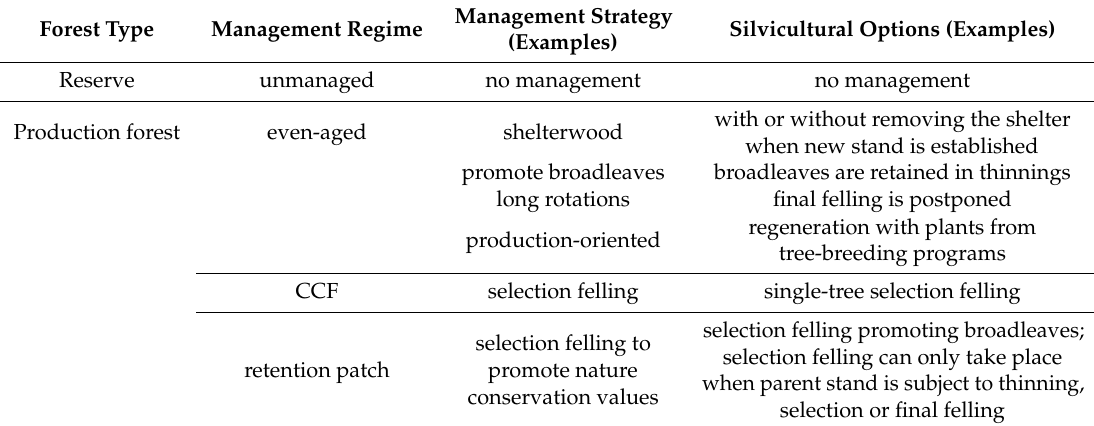
Table 2. Overview of management regimes and strategies. The list of management strategies for the even-aged regime is not extensive, so for more information see Appendix